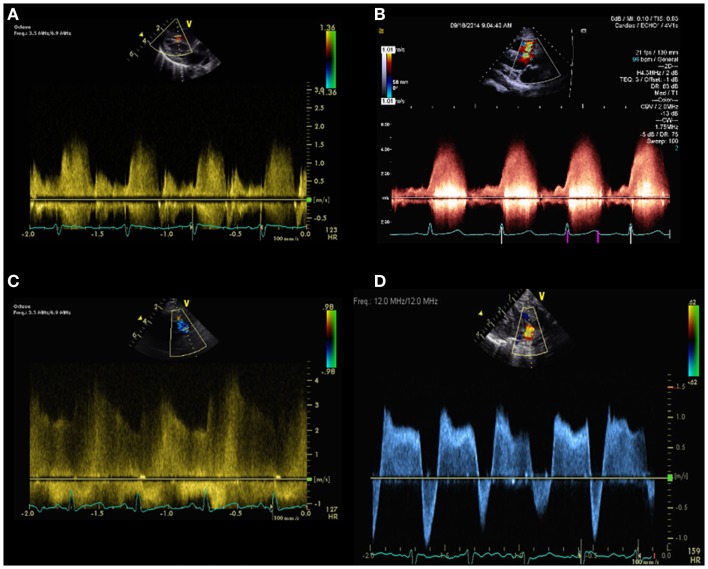
Spectral Doppler pattern across a ventricular septal defect with low velocity left to right shunt (A) indicating pulmonary hypertension and high velocity left to right shunt (B) indicating low pulmonary pressure. Spectral Doppler pattern across patent ductus arteriosus with continuous high velocity left to right shunt (C) indicating lower pulmonary artery pressure compared to aortic pressure and bidirectional shunt (D), indicating pulmonary hypertension.